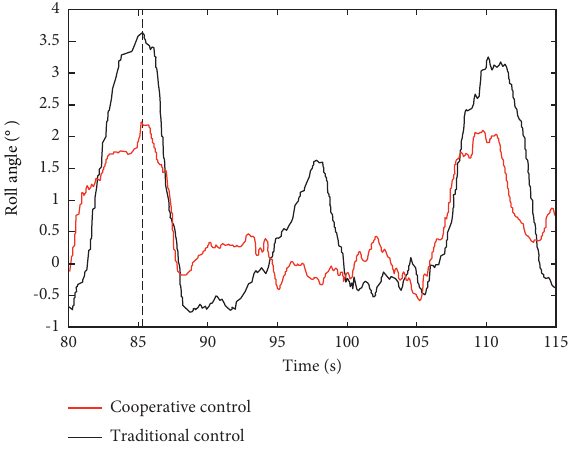
Figure 17: Segment vehicle roll angle